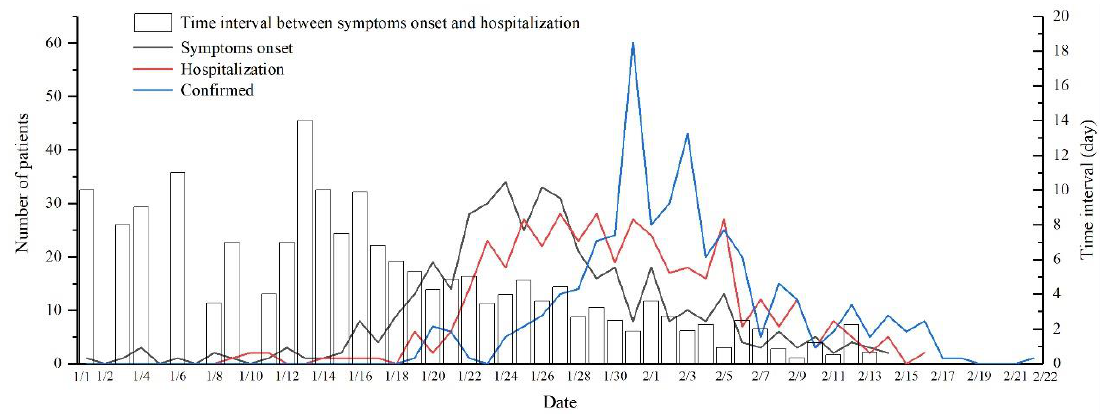
Figure 3. Temporal variation in COVID-19 cases.